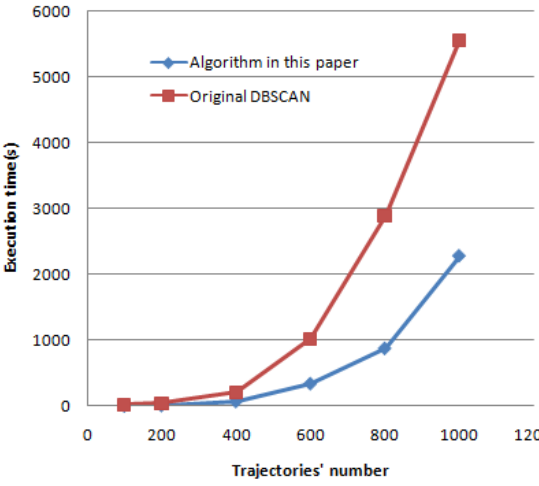
Figure 6. comparison of the algorithms’ execution